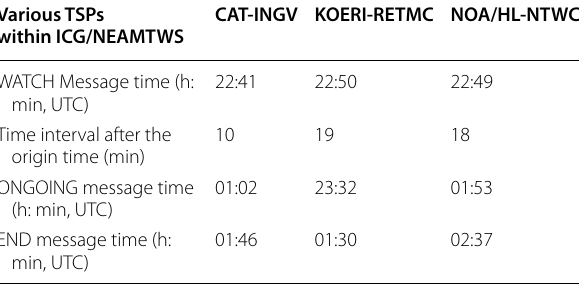
Earthquake origin time was July 20, 2017 at 22:31 UTC according to USGS